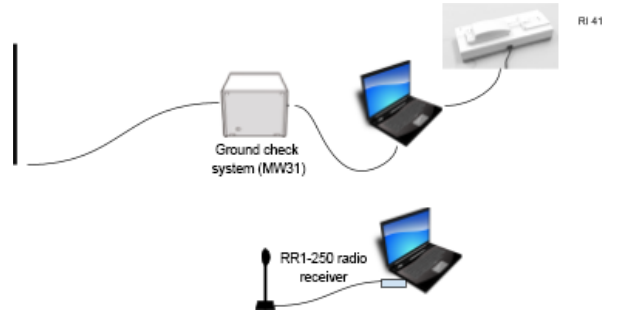
Figure 3. Experimental system set-up: antennae, sounding system, and ground check system (MW41).